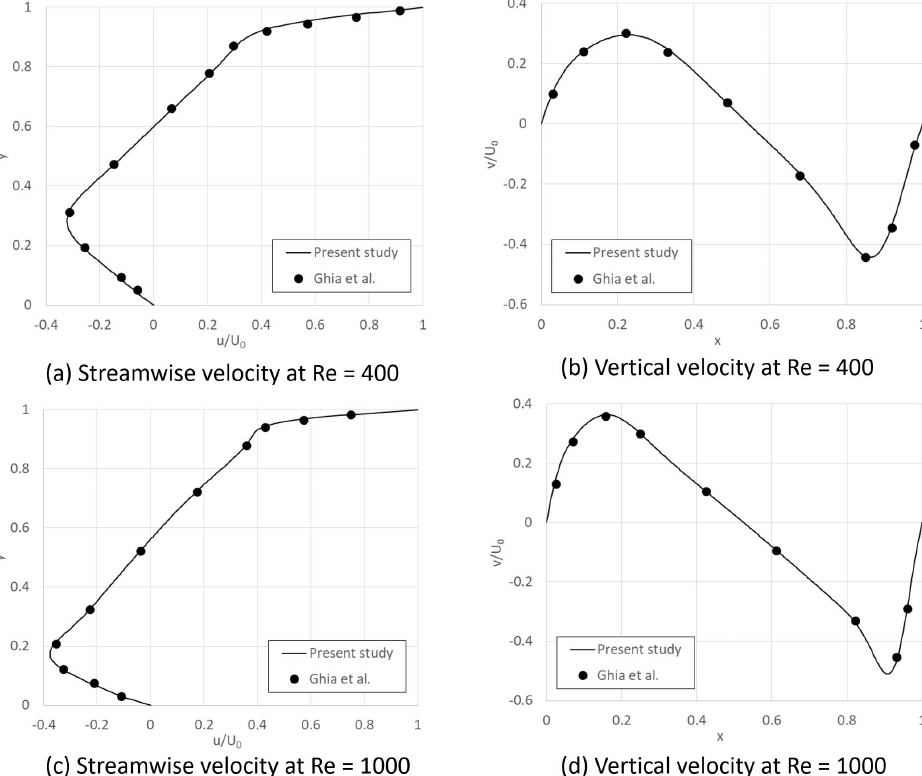
Figure 15. Variation of streamwise and vertical velocity profiles at the midplanes.